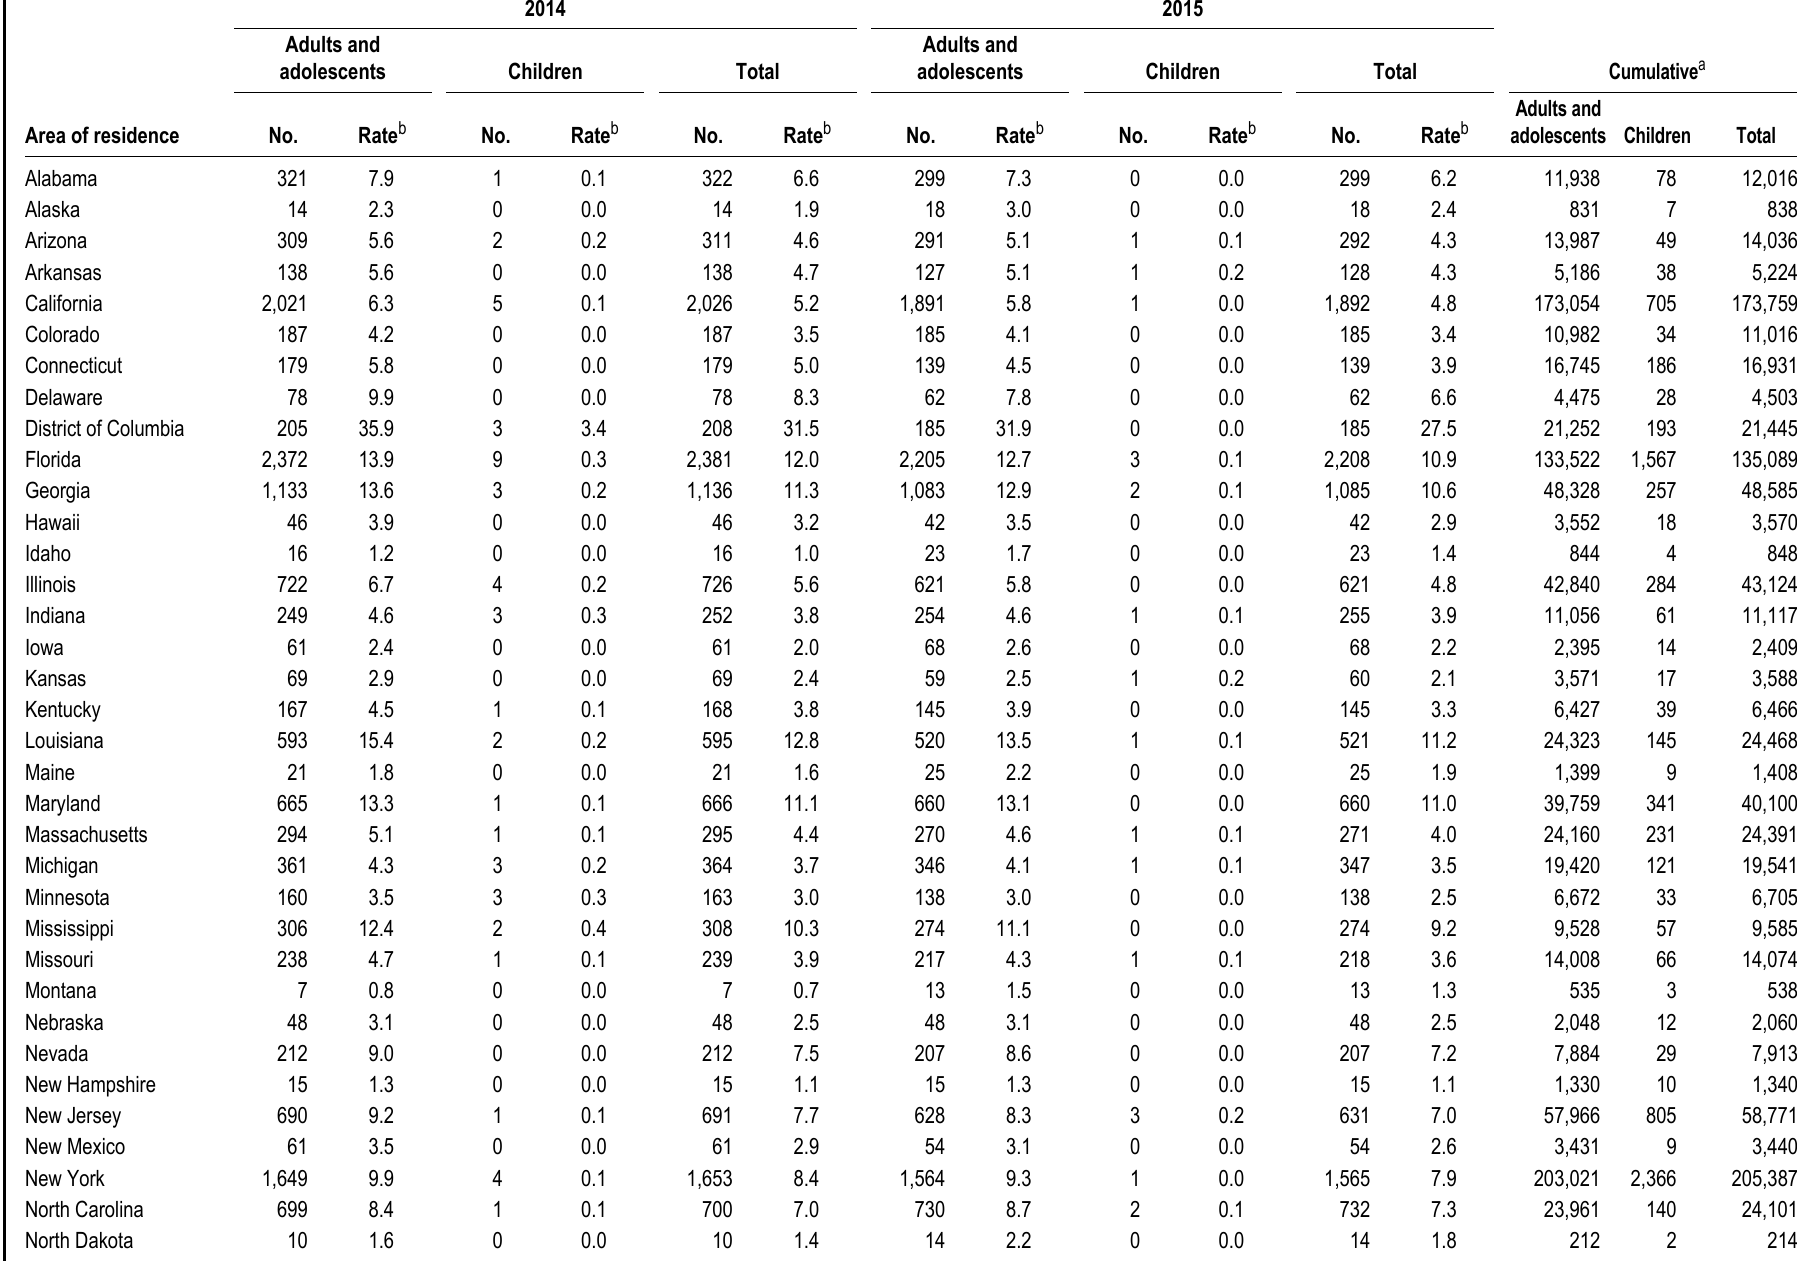
Table 23. Stage 3 (AIDS), by area of residence, 2014, 2015, and cumulative—United States and 6 dependent